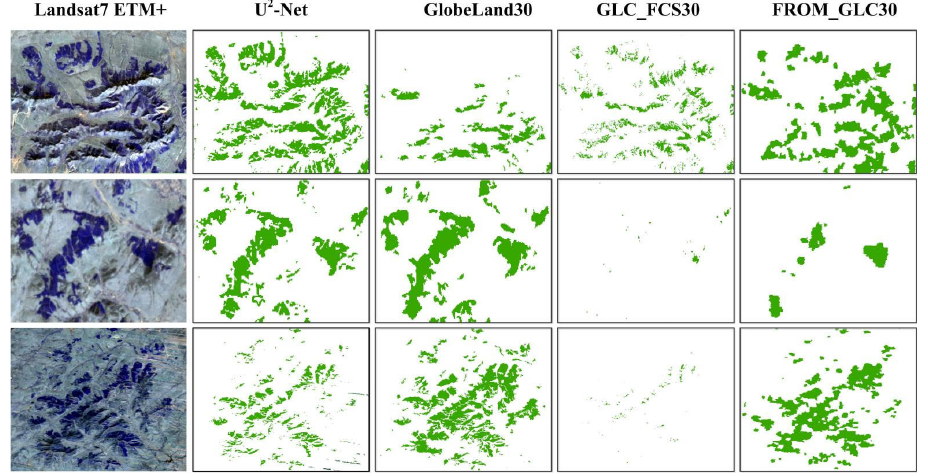
Figure 15. Comparison of the coniferous forest extraction results of U 2 ‐ Net with three public datasets (GlobeLand30, GLC_FCS30 and FROM ‐ GLC).